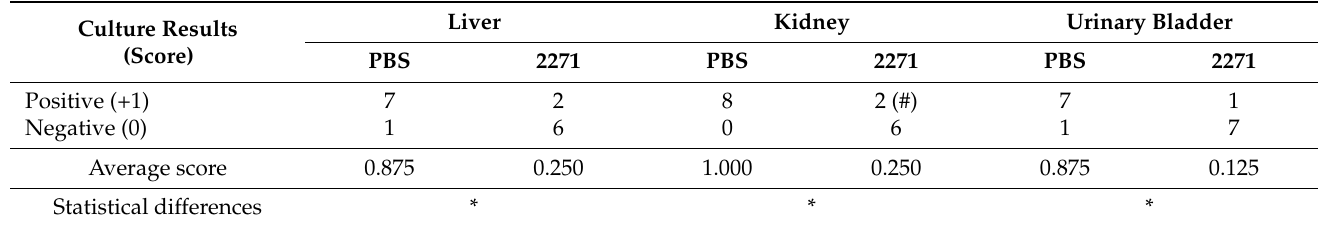
Table 1. The conclusive determination of the presence of Leptospira cultured from the liver, kidney, and urinary bladder from the Control ( n = 8) and immunized ( n = 8) animals after the challenge. The liver, kidney, and urinary bladder from the infected animals were cultured in EMJH medium and maintained at 30 ◦ C for 4 weeks. The growth of leptospires was monitored using dark-field microscopy. The visible f leptospires in culture samples were counted as positive, and those without visible leptospires were counted as negative. The * indicates the significant differences with a p -value < 0.05.